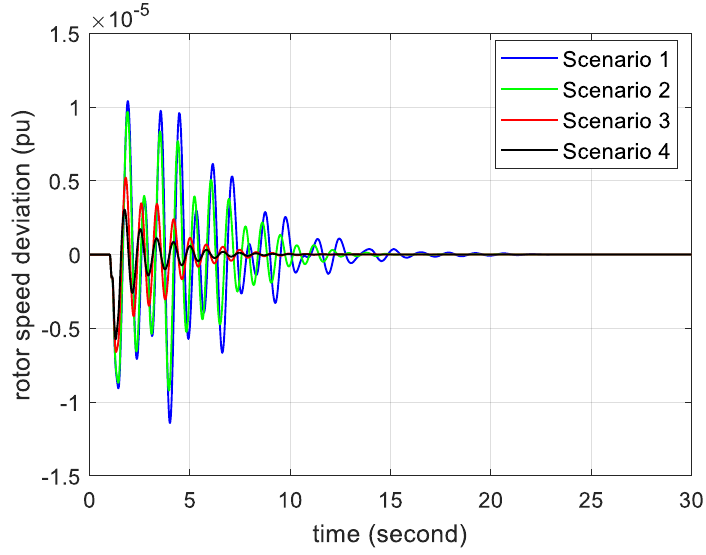
Figure 7. Rotor angle responses of G3.